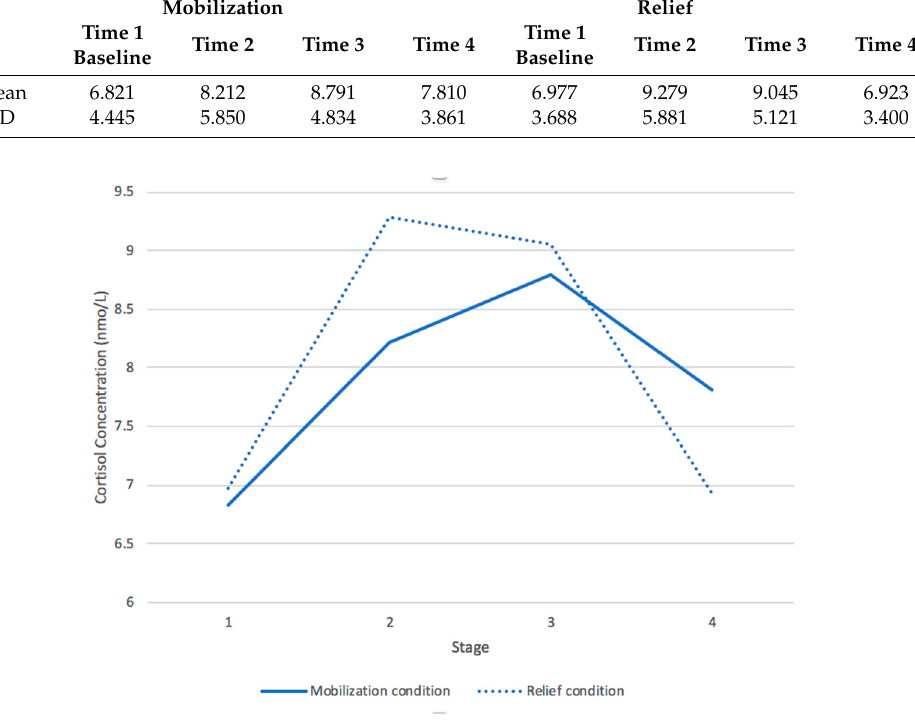
Figure 3. The change of salivary cortisol concentrations throughout four stages in two conditions.